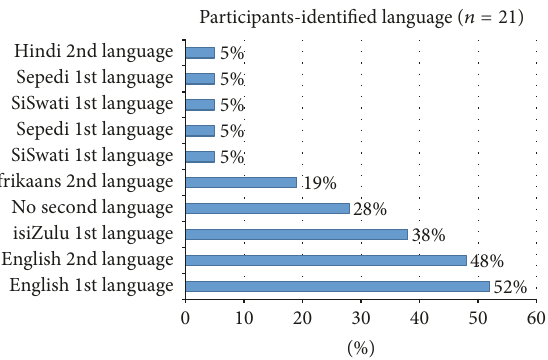
Figure 3: Participants identified language ( 𝑛 = 21